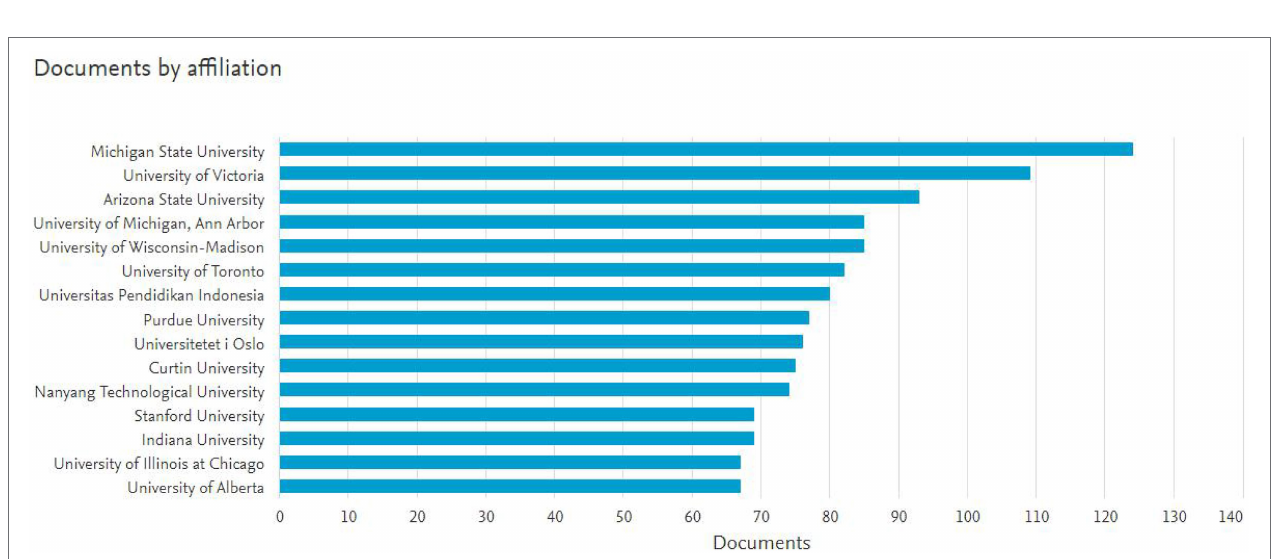
FIGURE 2 | Top 15 funding bodies as contributors in the field of scientific literacy between the years 1980 to 2019.